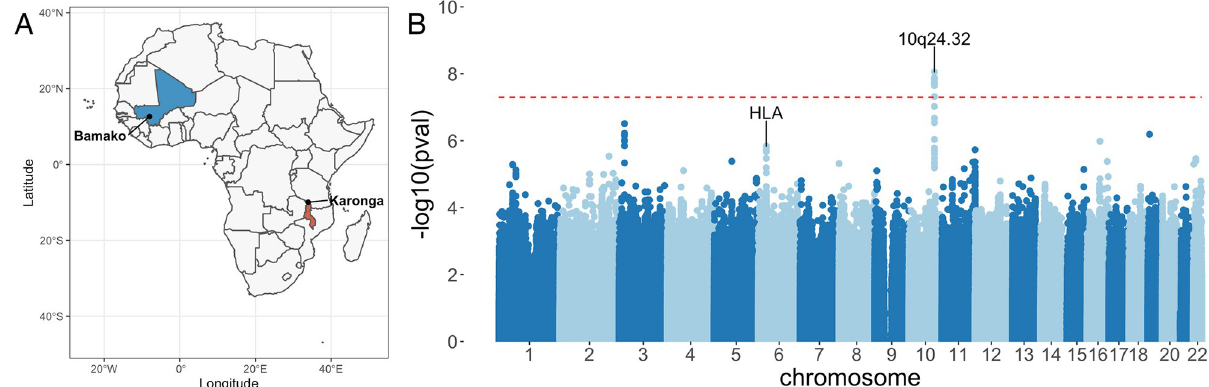
Fig 1. Genome-wide association study of leprosy in Malawi and Mali. (A) Study sites in Mali (blue) and Malawi (red). (B) Evidence for association with leprosy at genotyped and imputed autosomal SNPs and indels ( n = 9, 616, 523) in Malawi and Mali (492 cases, 639 controls). Association statistics represent a fixed-effects meta-analysis of additive association with disease in Malawi and Mali. The red, dashed line denotes genome-wide significance ( p = 5 × 10 − 8 ). Suggestive loci ( p = 1 × 10 − 5 ) identified in the meta-analysis are detailed in S2 Table. The map is based on public domain Natural Earth data; the base layer is available for download at https://www.naturalearthdata.com/.